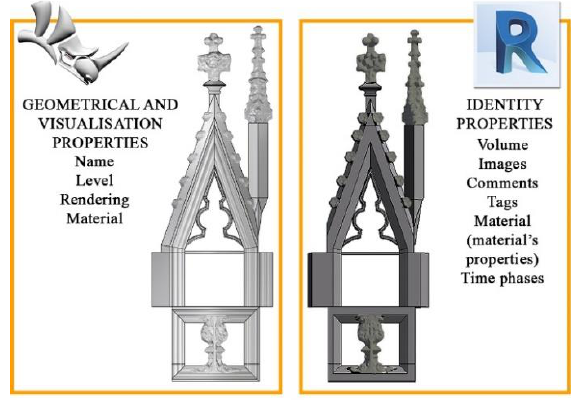
Figure 5. The two models in Rhinoceros (on the left) and in Revit (on the right).